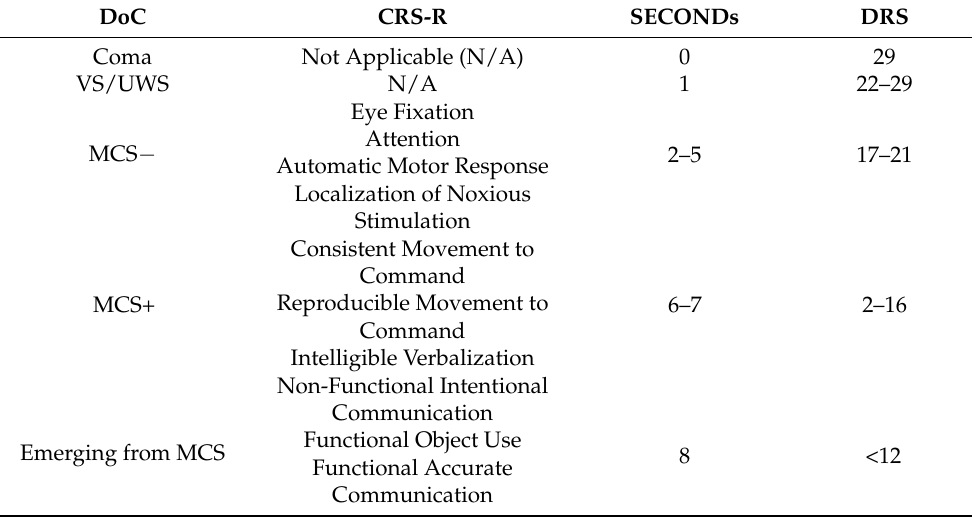
Table 3. Clinical scoring system relation to DoC